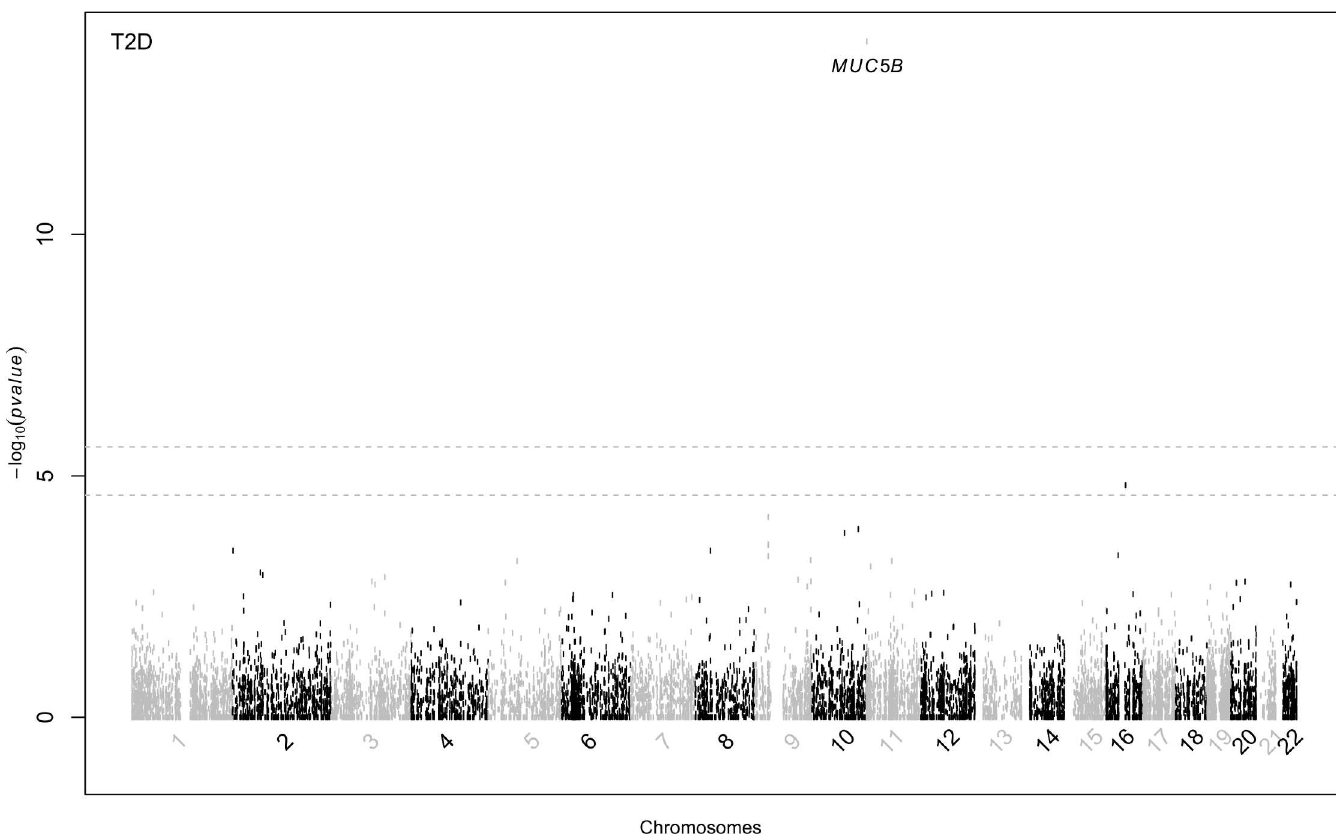
Fig 1. Exome ArrayAssociation Results. The y axis represents the–log 10 (p-value)and the x axis is variant positionsby chromosome. Genome-wide and suggestivestatistical significance thresholdsare illustrated by the two dotted lines.